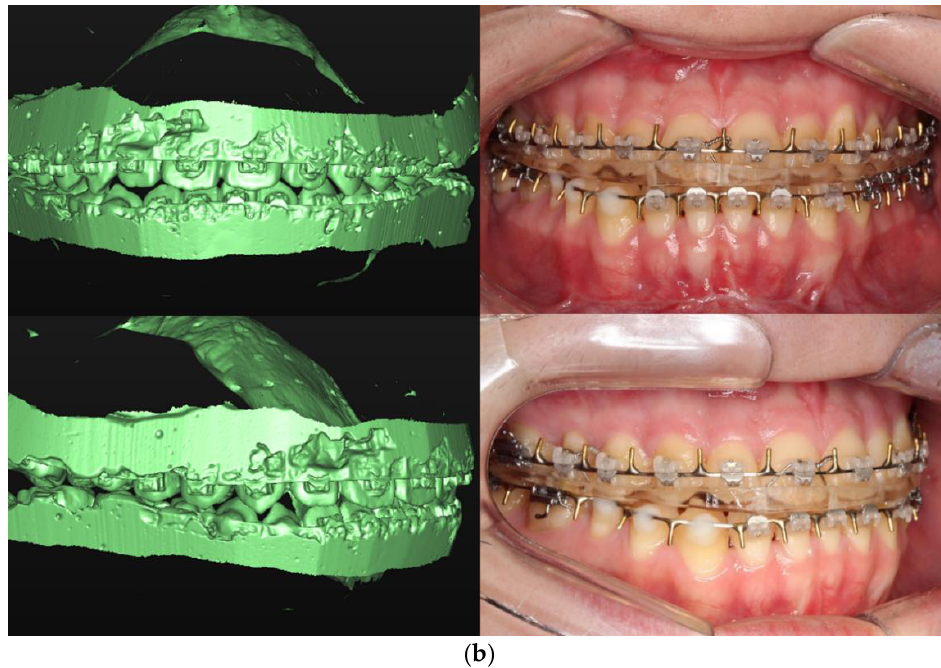
Figure 1. Scanned digital cast and intraoral photograph: ( a ) Preoperative occlusion, ( b ) Surgical occlusion setup and postoperative occlusion.